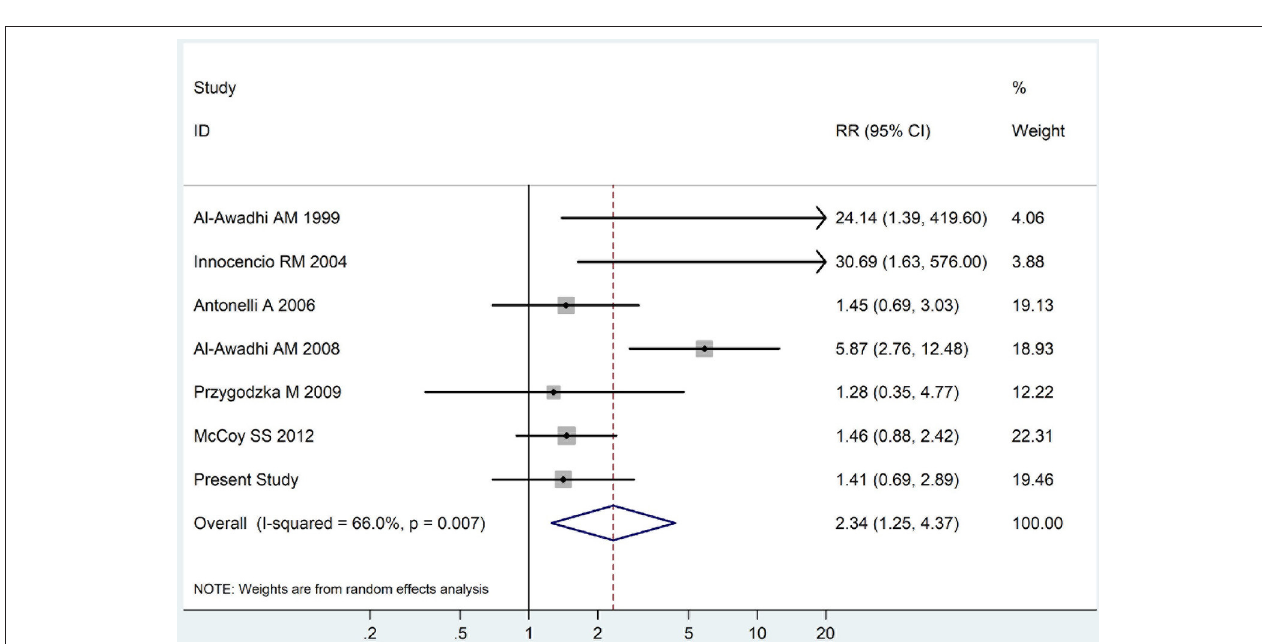
FIGURE 6 | Forest plot for the increased prevalence of subclinical thyroid dysfunction among RA patients (The diamond represents the pooled RR and 95% CI).